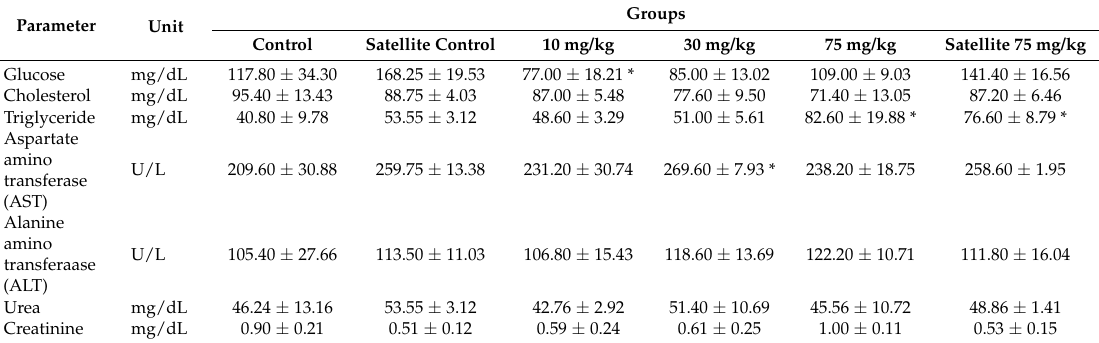
Table 5. Biochemical profile of male rats treated with different doses of the film formulation for 28